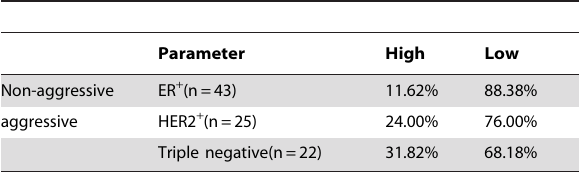
Table 1. The percentage of NEDD9 expression in breast